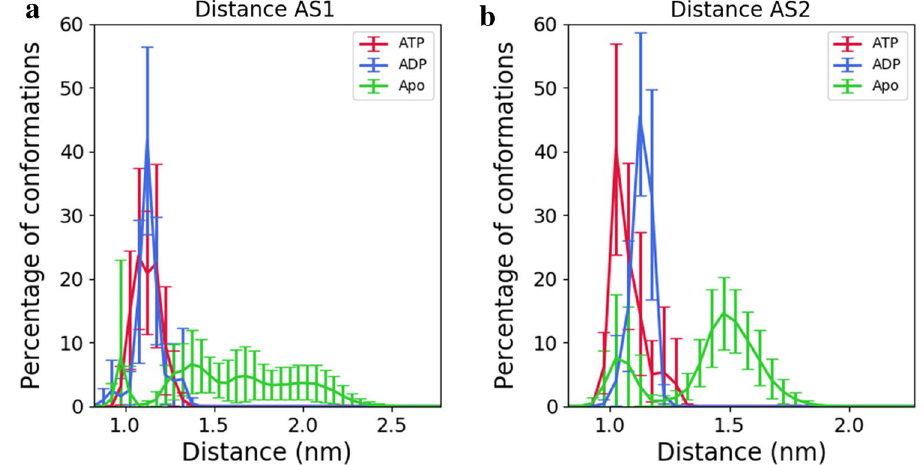
Figure 2. Distance of active site opening in both ATP binding pockets. AS1- Active site 1, AS2-Active site 2. This distance is measured between the C-α atoms of Walker A and the ABC motifs of the active site. The ATP state is represented in red, the ADP in blue and the Apo state without nucleotide in green. The last 260 ns of each trajectory were used for analysis. The error bars correspond to the 95% confidence interval obtained by bootstrapping. The AS1 is formed by the MalK chain ( b ) Walker ( a ) motif and the chain ( a ) ABC motif, while the AS2 is formed by the chain ( a ) Walker ( a ) motif and by the chain ( b ) ABC